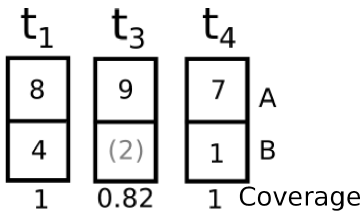
Figure A2. Schematic demonstrating coverage. Velocities are filled with linear interpolation in time, and coverage is weighted by dis- charge. t columns represent the same two gate pixels (A and B) at three time steps, where t n values are linearly spaced, but t 2 is not observed anywhere on the ice sheet and therefore not included. Numbers in boxes represent example discharge values. The gray parenthetical number is filled, not sampled, in pixel B at time t 3 . Weighted filling computes the coverage as 9 / 11 = 0 . 81, instead of 0.5 (half of the pixels at time t 3 have